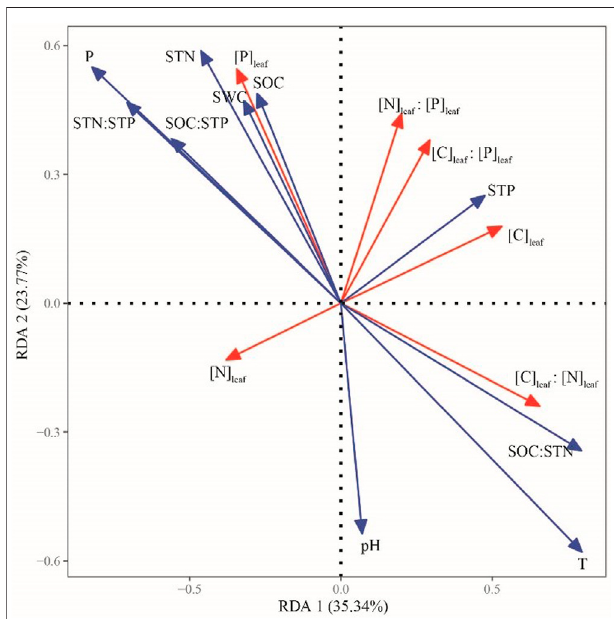
FIGURE 3 | Redundancy analysis (RDA) ordination for the leaf stoichiometric traits of L. virgaurea and environmental characteristics. pH, soil pH; SWC, soil water content; SOC, soil organic carbon concentration; STN, soil total nitrogen concentration; STP, soil total phosphorus concentration; [C] leaf , leaf carbon concentration; [N] leaf , leaf nitrogen concentration; [P] leaf , leaf phosphorus concentration; T, temperature; P, precipitation.